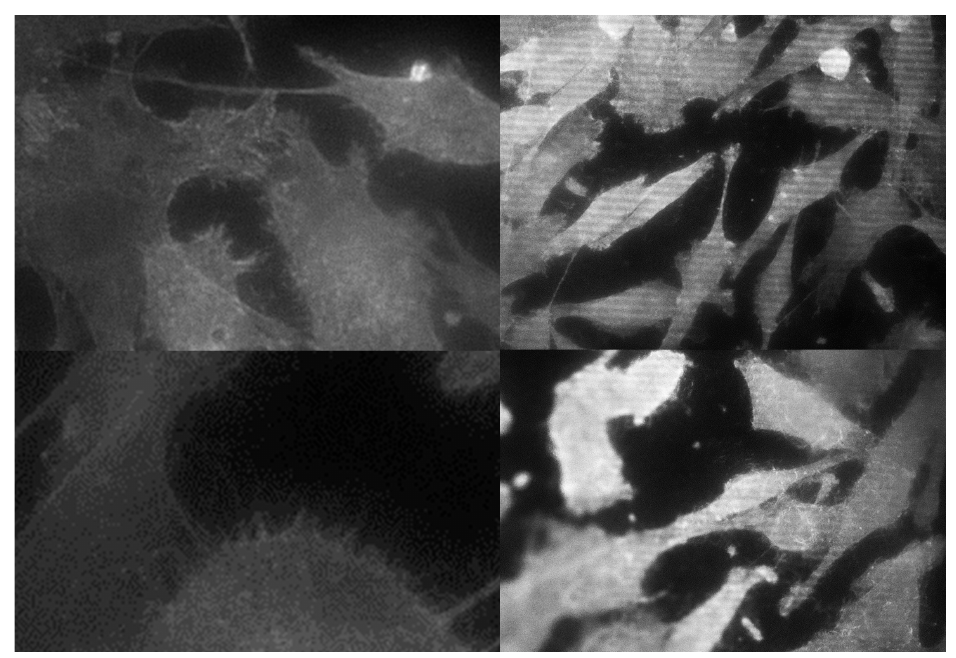
Figure 1. Confocal microscope images of MG-63 on the GR4NT surface (top left), GR4TR (top right), GR5NT (bottom left) and GR5RT (bottom right) at 40 × magnification (details, approximately 150 × ). Philopodia-like cell processes can be observed in the images.